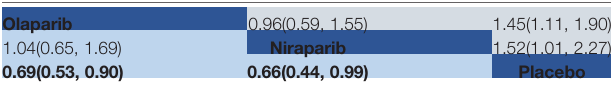
TABLE 2 | The network meta-analysis of OS in gBRCA-mutated patients.